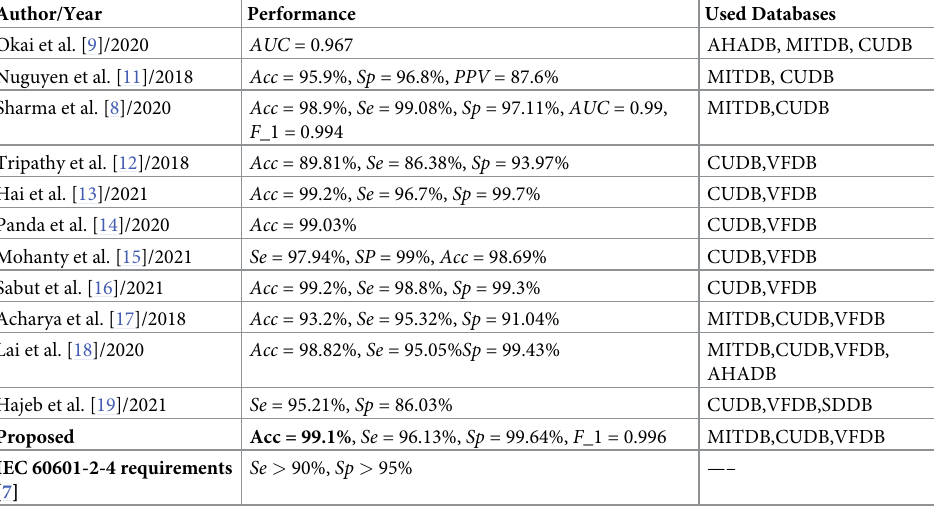
Table 3. State-of-the-art deep learning methods used for automated detection of shockable ECG